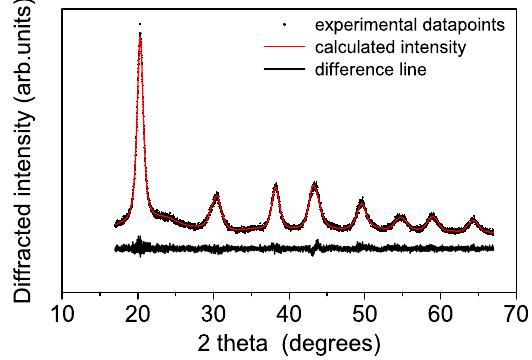
Figure 1. Synchrotron diffraction patters of the synthesized samples fitted by Rietveld method using the GSAS software.